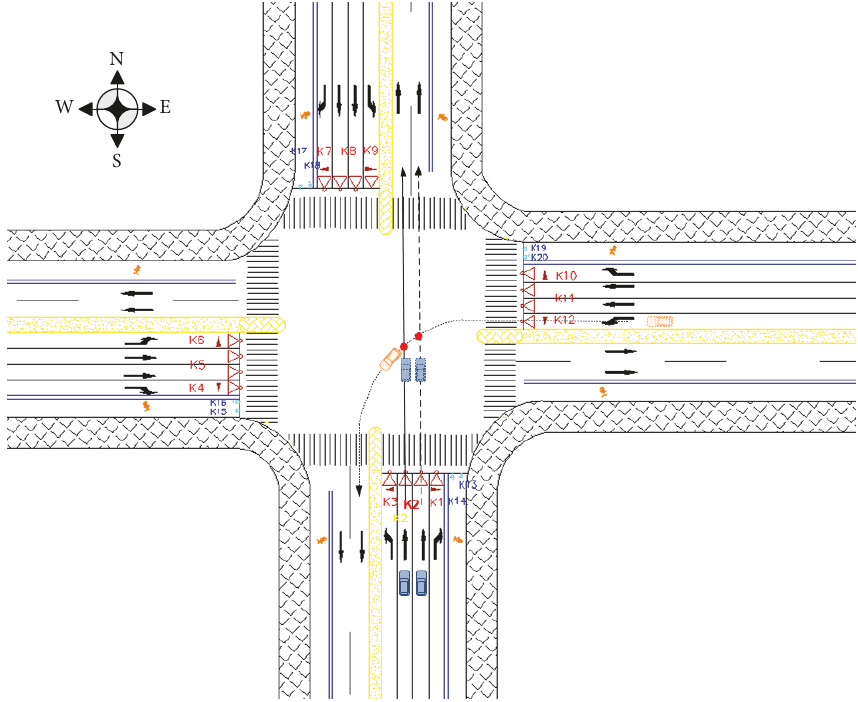
Figure 2: Signal groups of a typical four-leg signalized